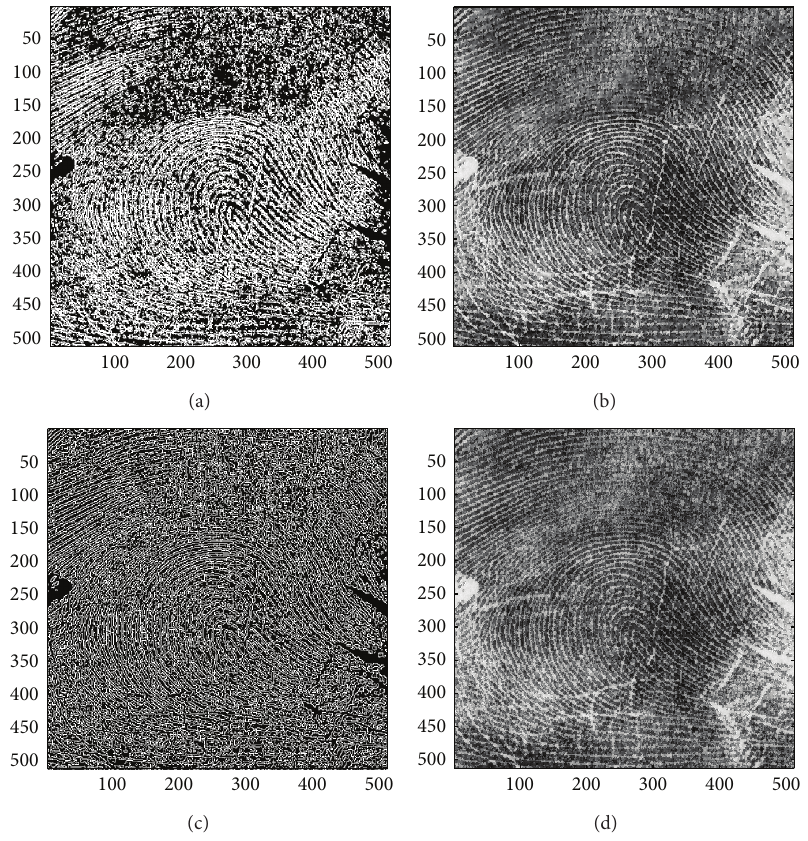
= 18 in the image “Finger.” (b) Result by HVD with scaling factor 𝑠 = 1.0 . (c) Edges detected Figure 11: (a) Edges detected by HVD with 𝜃 eth by Canny operator in the image “Finger.” (d) Result by Canny operator with scaling factor 𝑠 = 1.0 .